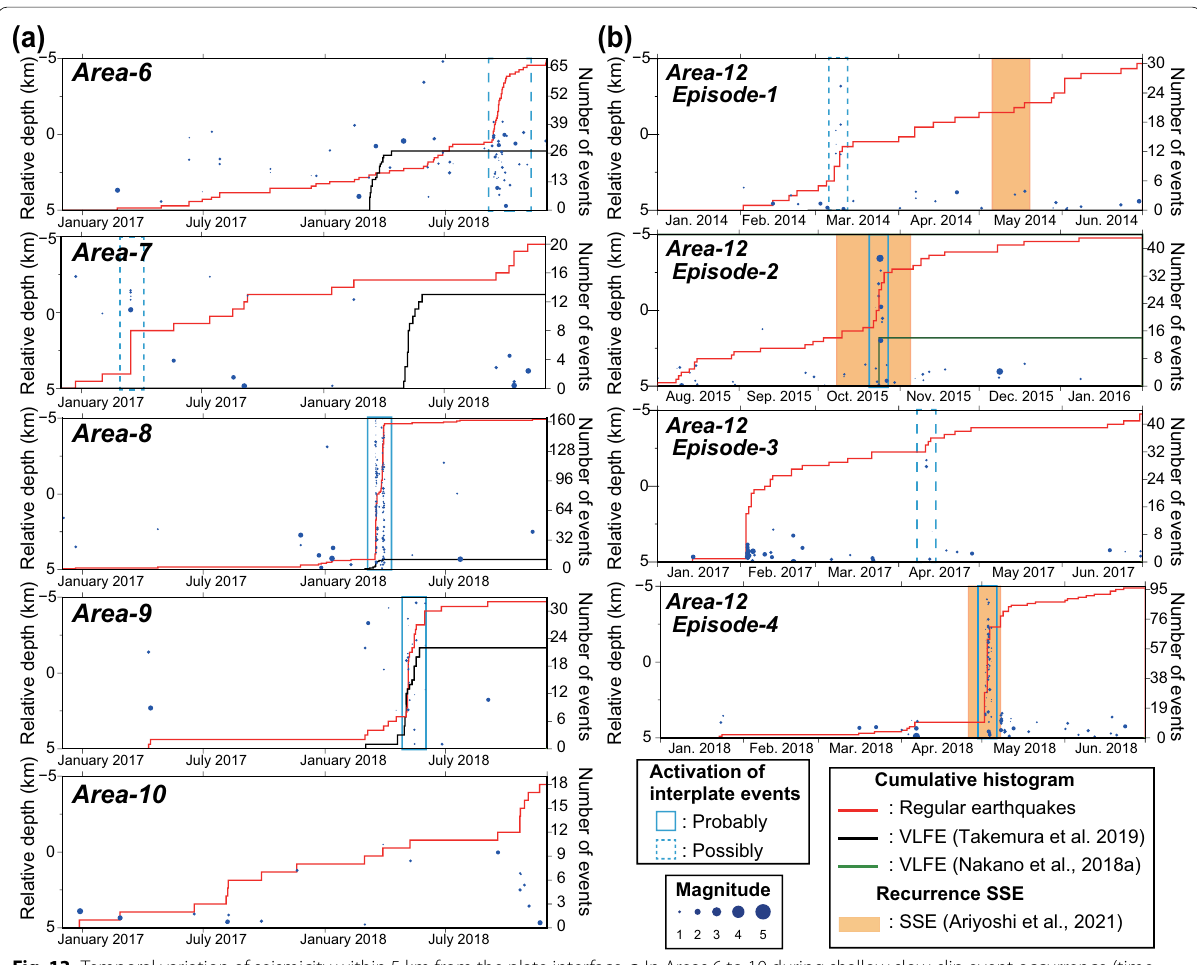
Fig. 13 Temporal variation of seismicity within 5 km from the plate interface. a In Areas 6 to 10 during shallow slow-slip event occurrence (time window is 2 years), b in Area 12 around the time when swarm-like activity was observed (time window is 6 months). The black line in a and green line in b are the cumulative number of VLFEs reported by Takemura et al. (2019) and Nakano et al. (2018a), respectively. Light-blue boxes reflect the confirmed activation of interplate seismicity as read visually; dotted boxes are less clear than the solid boxes. Other symbols are the same as in Fig.